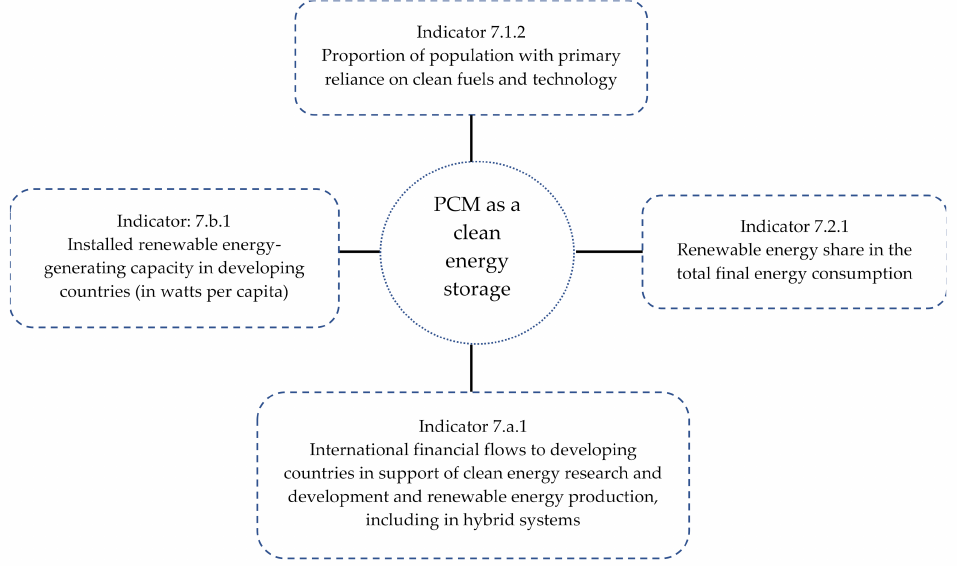
Figure 9. Contribution of PCM in attainment of UN SDGs